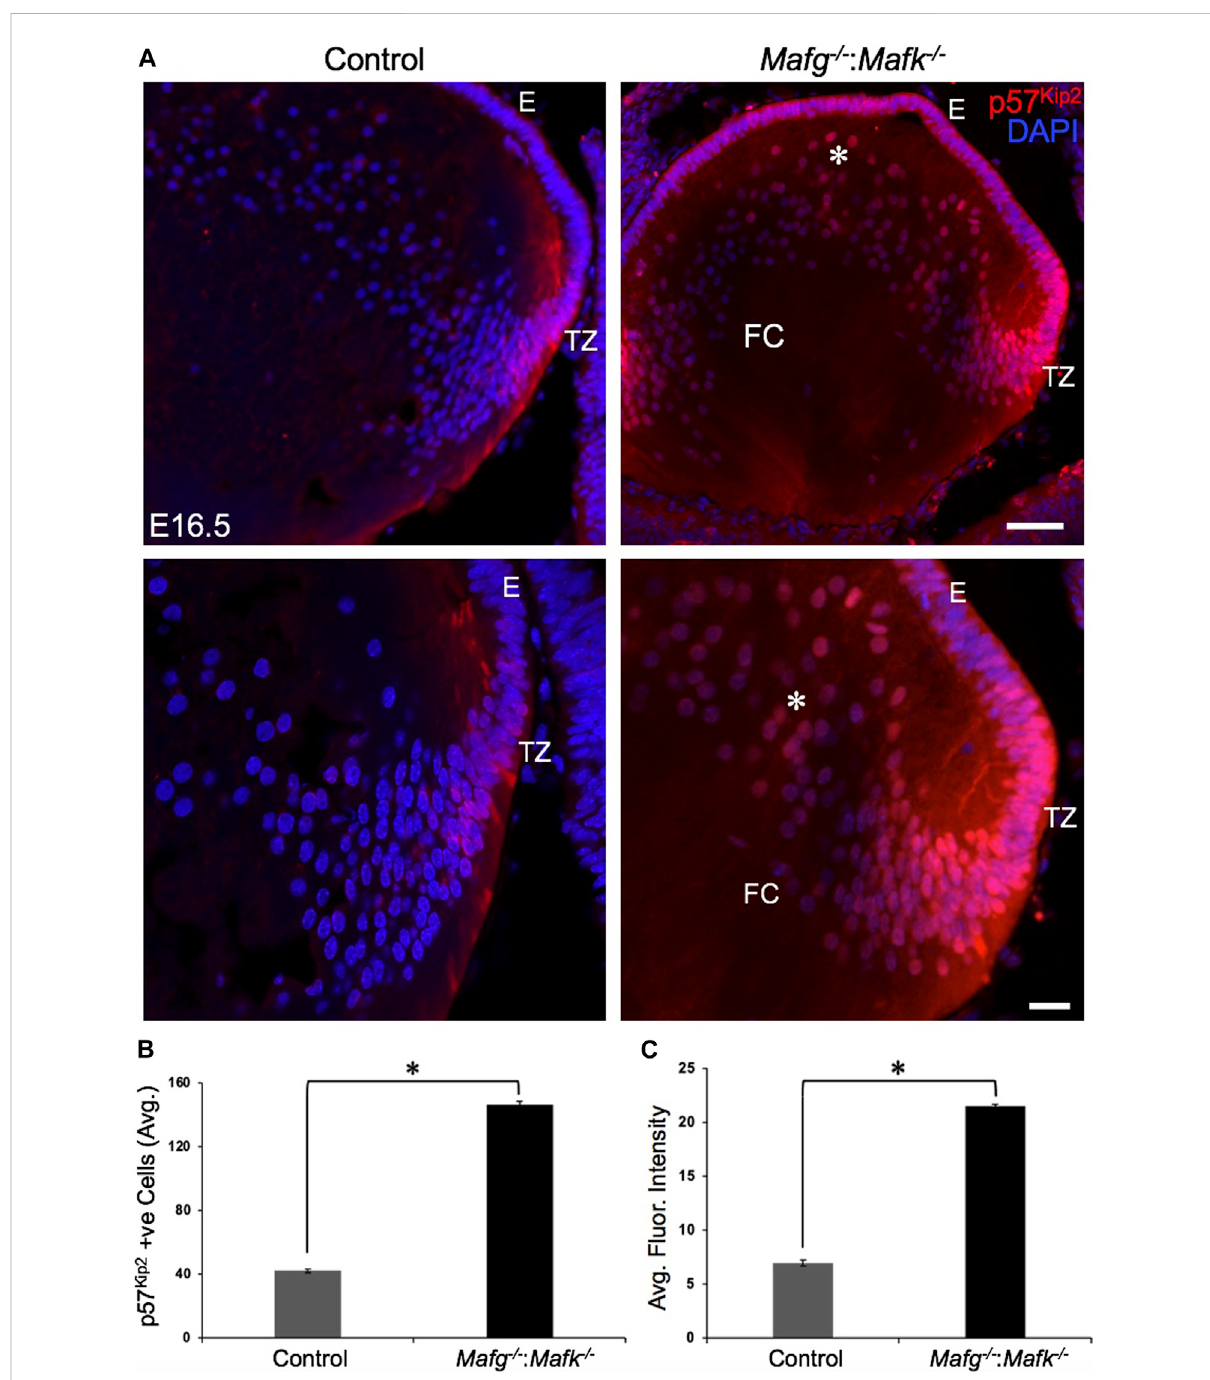
FIGURE 9 Cdkn1c (p57 Kip2 )protein levels are elevated in Mafg − / − : Mafk − / − lens. (A) Immunostaining shows Cdkn1c (p57 Kip2 )protein levels are elevated in the transition zone and in fi ber cells (asterisk) in E16.5 Mafg − / − : Mafk − / − lenses compared to control. (B) Quanti fi cation of cells from transition zone and fi ber compartment exhibiting Cdkn1c (p57 Kip2 ) signal in Mafg − / − : Mafk − / − lenses compared to control. (C) Quanti fi cation of average fl uorescence intensity of Cdkn1c (p57 Kip2 ) signal in Mafg − / − : Mafk − / − lenses compared to control. Statistical signi fi cance was determined using a two-sample Student ’ s t -test. Abbreviation: E, Epithelium of the lens; FC, Fiber cells of the lens; TZ, Transition zone of the lens. Scale bar for Row 1, 10 μ m; Row 2, 8 μ m. Asterisk in (B) and (C) indicates p ≤